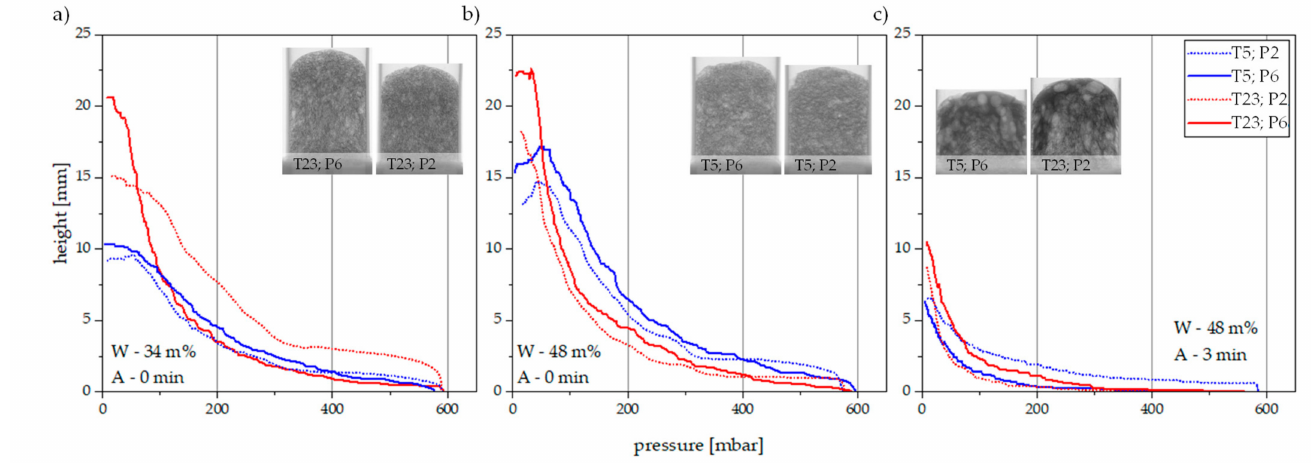
Figure 3. Foaming as a function of decreasing pressure (( a )-W34A0, ( b )-W48A0, ( c